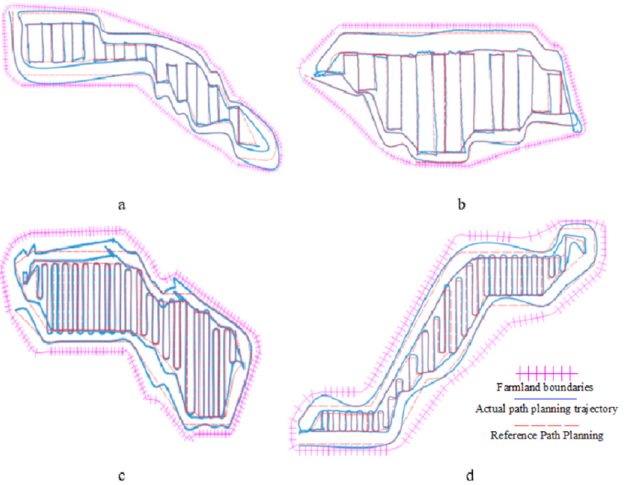
Figure 12. Verification of the path trace results for the experiment. ( a ) represents the path tracking result of field block 1; ( b ) represents the path tracking result of field block 2; ( c ) represents the path tracking result of field block 3; and ( d ) represents the path trace result of field block 4.